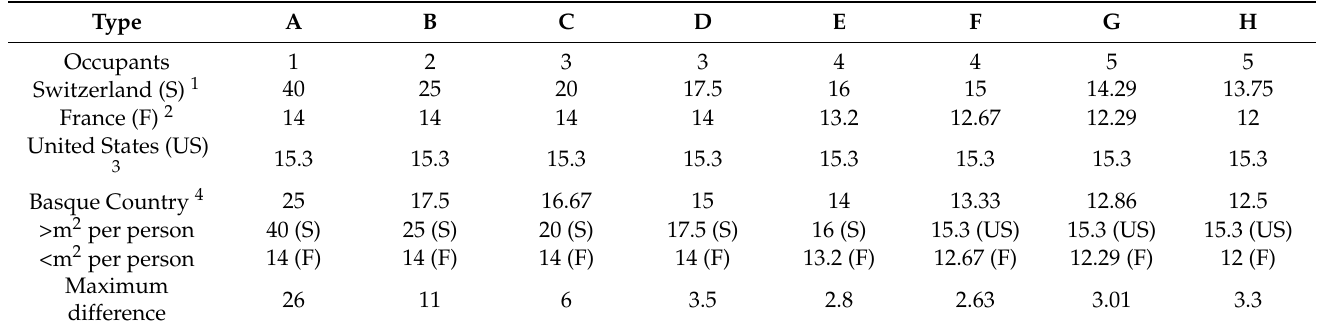
Table 10. Living space per person [m 2 per person], according to different regulations.